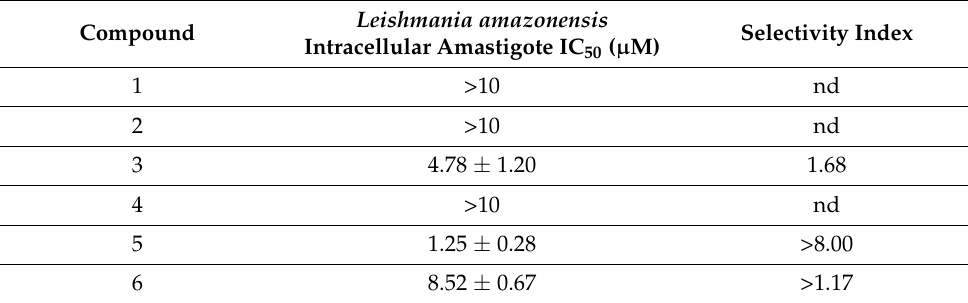
Table 3. Leishmanicidal activity against intracellular amastigote stage of the best compounds